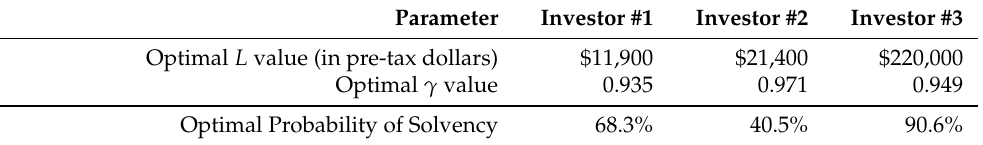
Table 4. Optimal tax strategies for the three example investors, along with the optimal probability of solvency found using both the optimal investment strategy given in Figure 2 and the optimal tax strategy given here. L is the desired amount of consumption (in pre-tax, t = 0 dollars) from sources subject to income tax, such as the TDA, earned income, Social Security, and taxable bond interest. γ is a pre-tax to post-tax conversion correction factor.